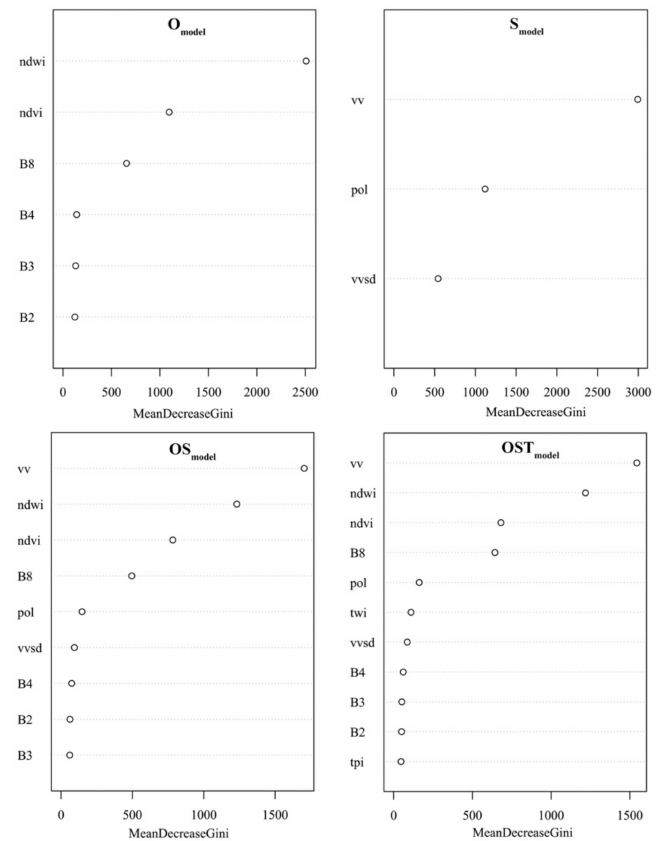
Figure 8. Input variable importance according to the Gini index of the random forest models including O model , S model , OS model , and OST model